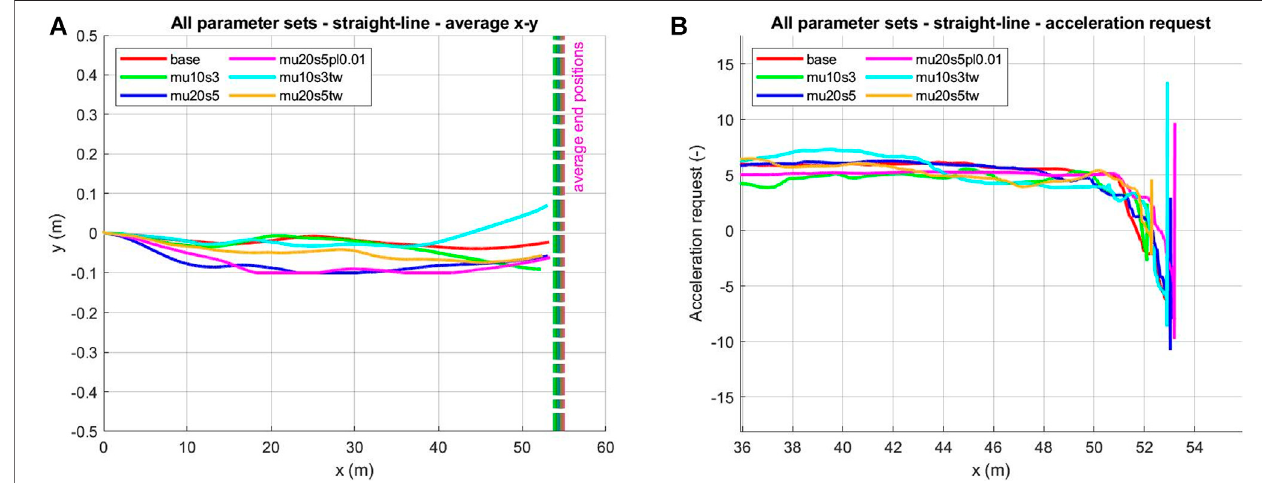
FIGURE 6 | Straight-line brake test (HiL). (A) Average position x – y . (B) Average acceleration request.